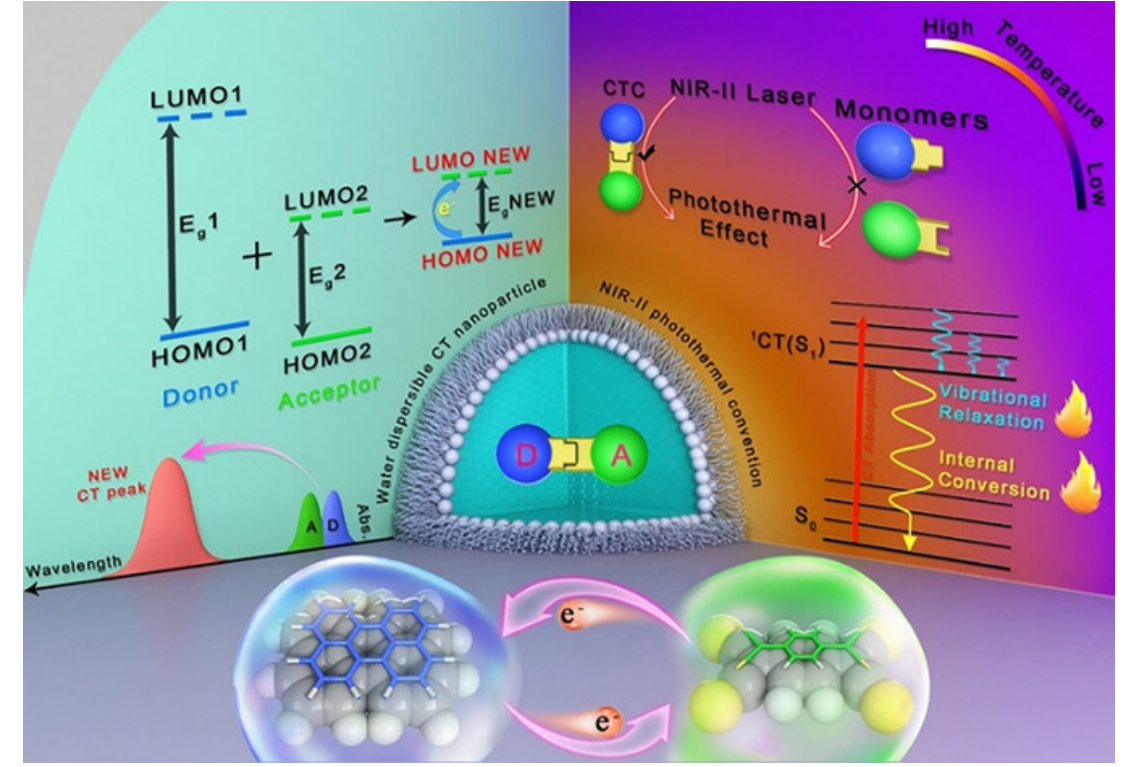
Figure 12. Diagram showing photothermal effect in charge transfer cocrystal nanoparticle. Reprinted with permission from Ref. [106]. Copyright 2021 Wiley-VCH.